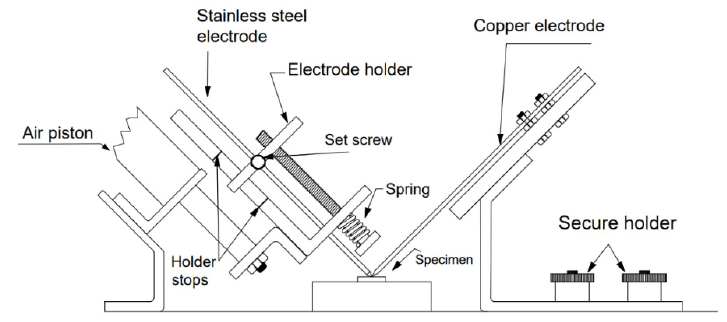
Figure 9. Electrode positioning and operating mechanism in HAI. Adapted from [109] .